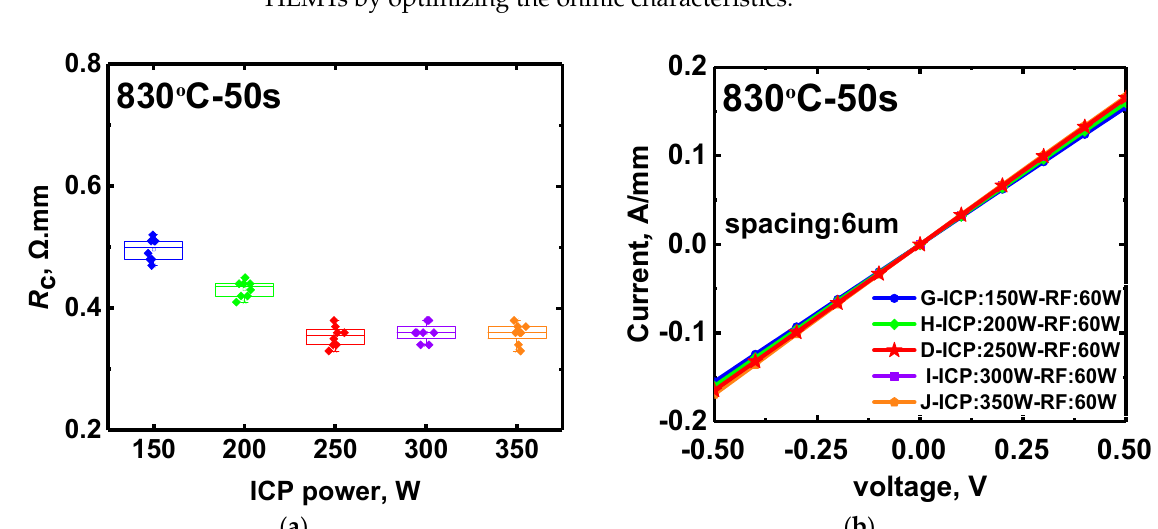
Figure 6. Impact of radio frequency (RF) power on R C . ( a ) R C with different RF power. ( b ) I–V characteristic curve of different RF power.